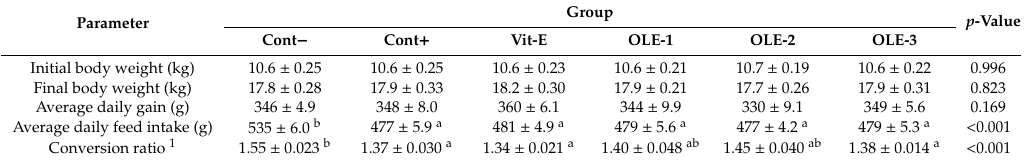
Table 3. Growth performance of piglets fed the experimental diets ( n = 8 / group).